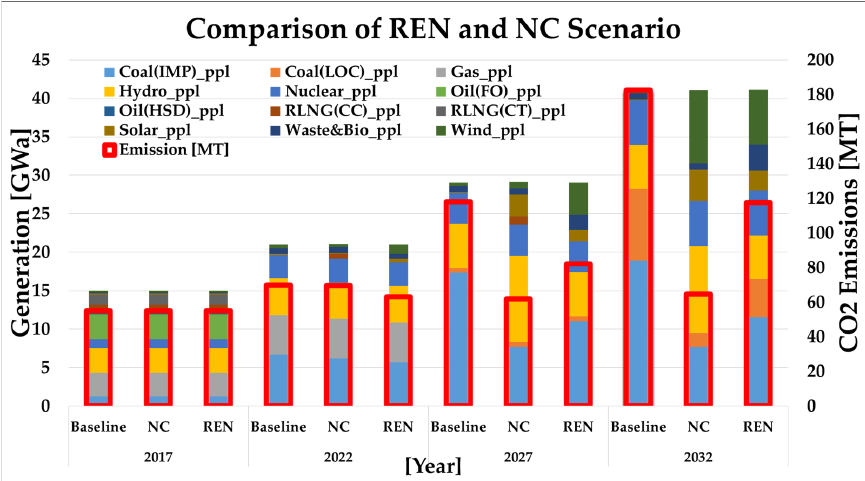
Figure 13. The comparison of REN and NC Scenarios with the baseline. Table 18. Summary of analysis of different scenarios on the supply side.